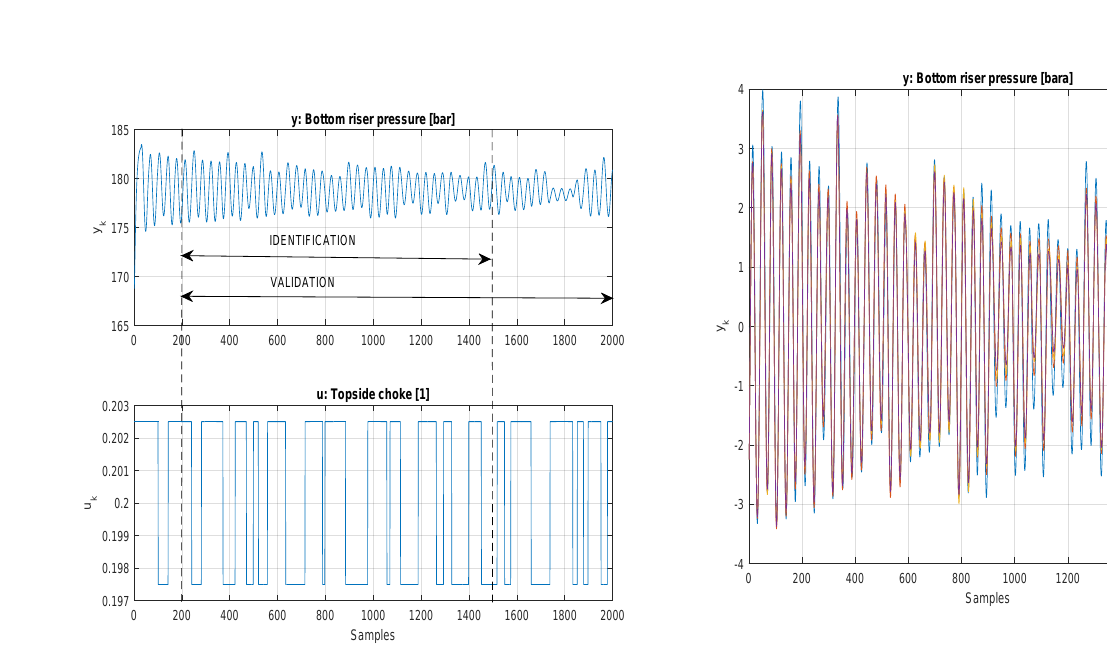
Figure 9: Identified dsr model simulated over the vali- dation set. V DSR 12 3 = 0 . 0862. @0.20